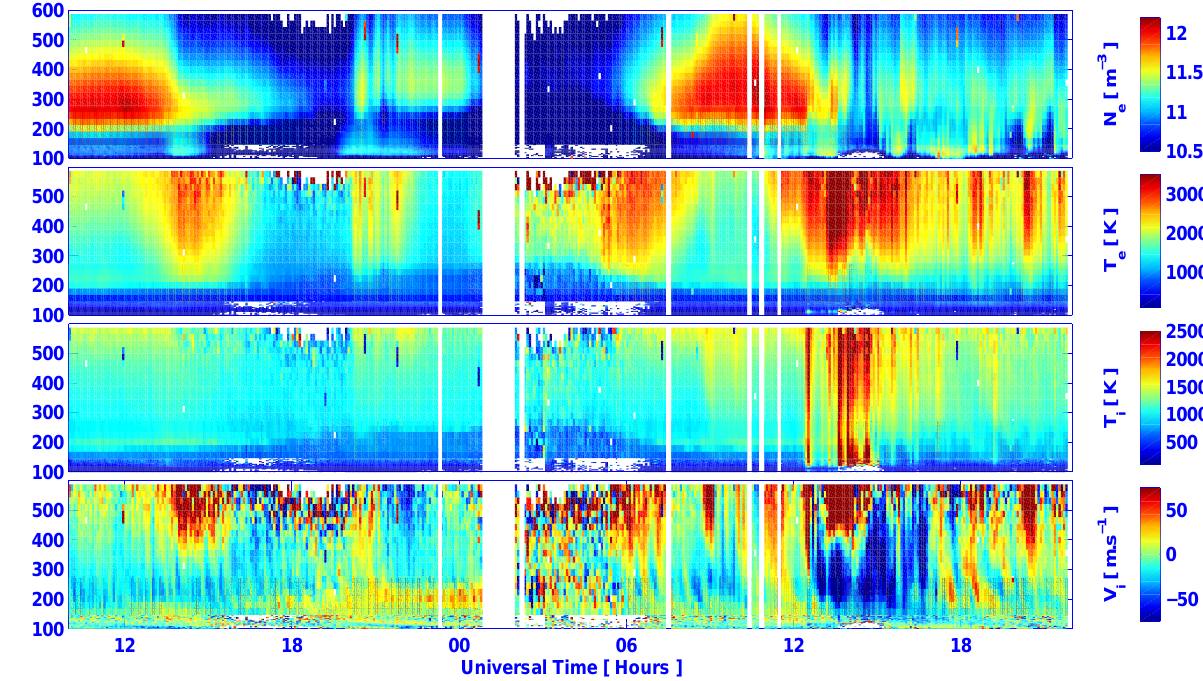
Fig. 5. From top to bottom: Time/altitude color plot of the electron concentration (Log 10 scale), the electron temperature, the ion temperature and the line of sight ion velocity, from UHF CP1 Common Program observations, for the same period as Fig. 4. Local noon corresponds to 10:40